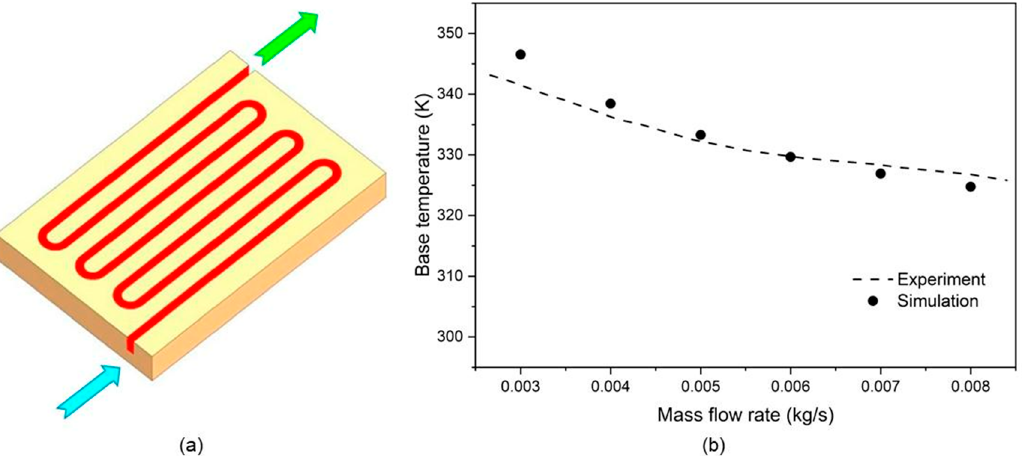
Figure 5. Simulation model validation with experimental results of serpentine heat sink from [31]: ( a ) Serpentine heat sink configuration; ( b ) Base temperature comparison. Reproduced with permission from Elsevier [31].